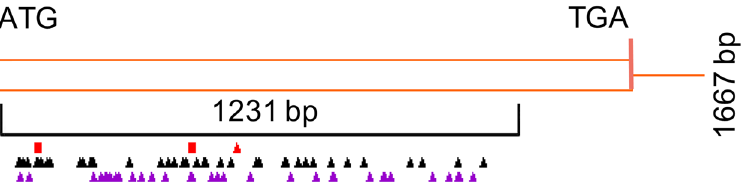
Fig 1. Distribution of SNPs and In-dels in CYC-B gene. Variants identified using Eco-TILLING and Sanger sequencing, and from tomato structural variant browser are represented with a modified PARSESNP output diagram. Black and purple triangles indicate the positions of nonsynonymous and synonymous nucleotide substitutions respectively. Red triangle represents the position of the nonsense substitution G570A in tomato accession EC20636. The red squares represent frameshift